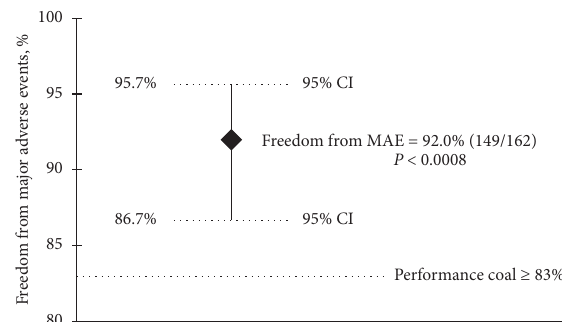
Figure 2: Freedom from major adverse events through 30 days in patients receiving the Emboshield NAV6 filter. CI, confidence interval; MAE, major adverse